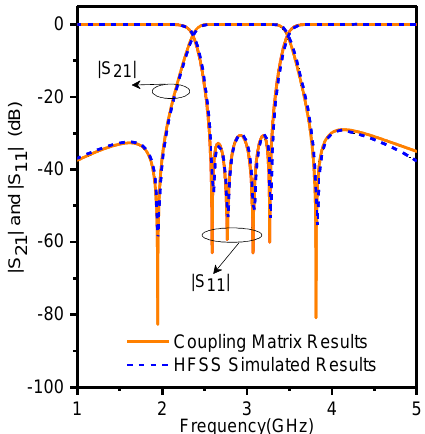
Figure 4. Coupling scheme of the quadruple-mode filter.